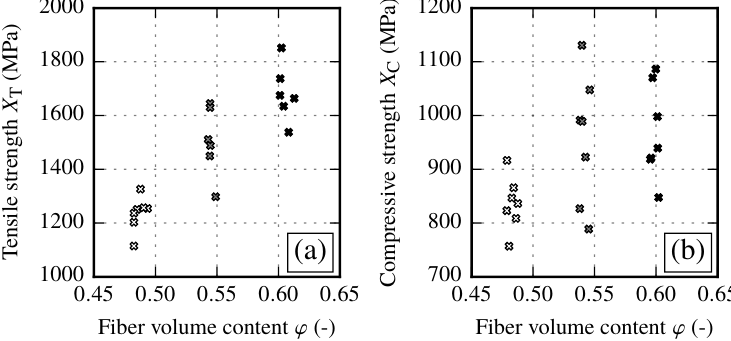
Figure 8. Reference samples—tensile and compressive strength in fiber direction X T ( a ) and X C ( b ) vs. different fiber volume content values.